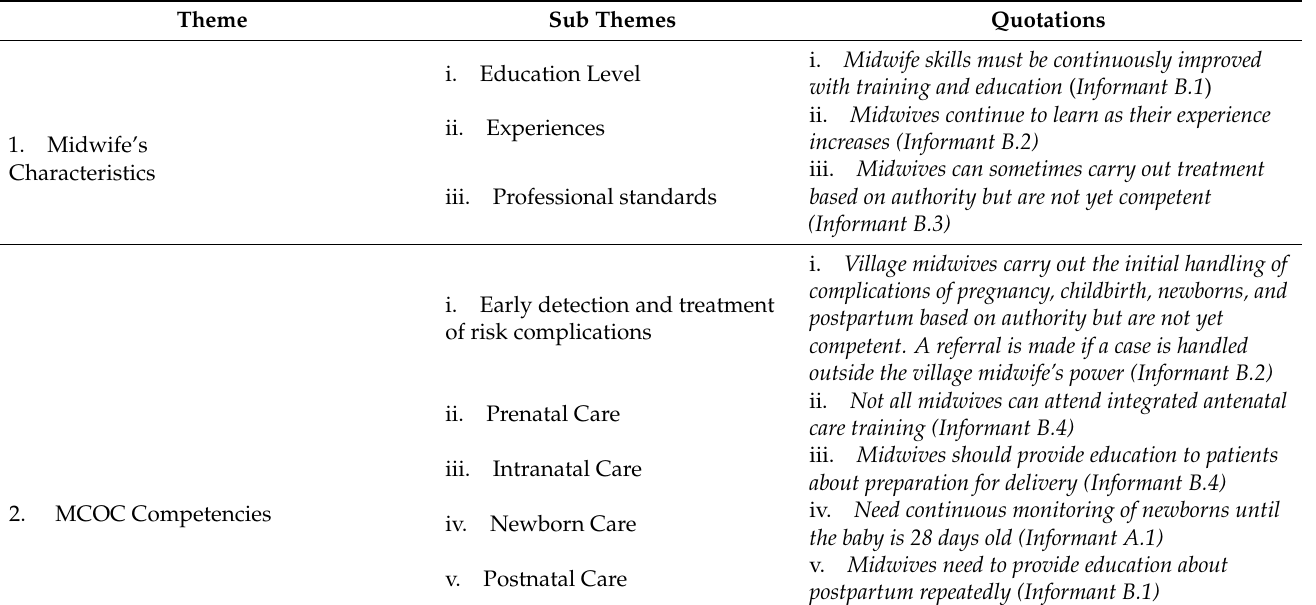
Table 5. Themes and sub-themes competence and service needs in the MCOC education and training